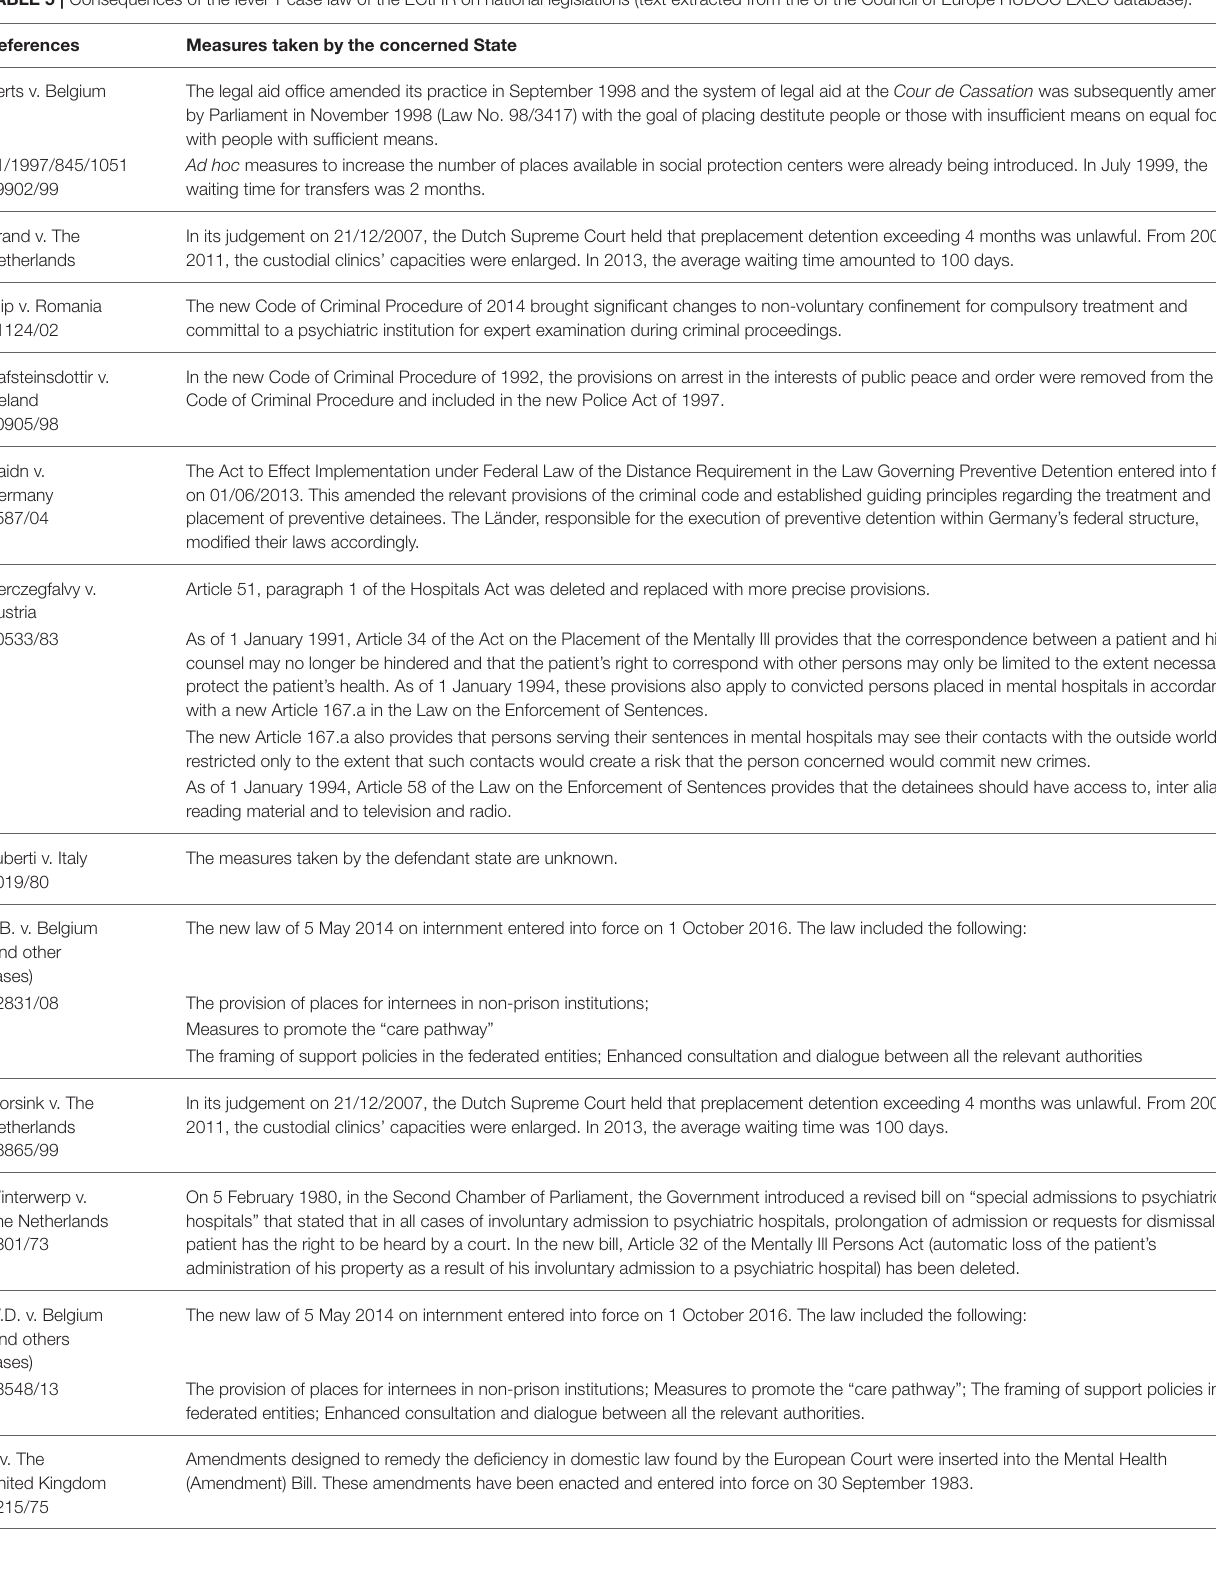
TABLE 5 | Consequences of the level 1 case law of the ECtHR on national legislations (text extracted from the of the Council of Europe HUDOC EXEC